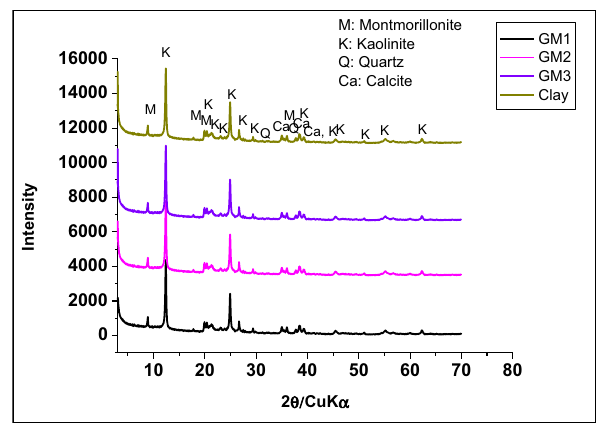
Figure 2: X ray di ff raction patterns of geomaterials and